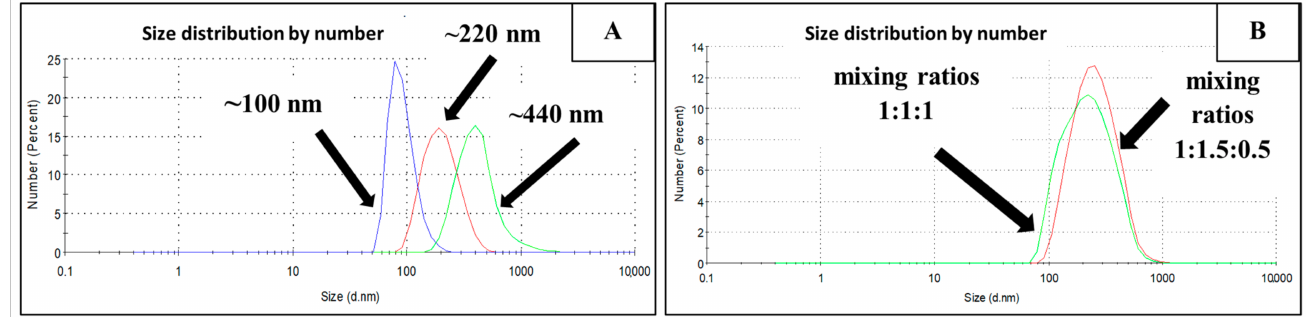
Figure 4. ( A ) The size distributions of the individual dispersions and ( B ) polydisperse dispersions of Ni-Ag NPs as mixtures of Ni-Ag NPs with ratio 1:1:1 and 1:1.5:0.5.